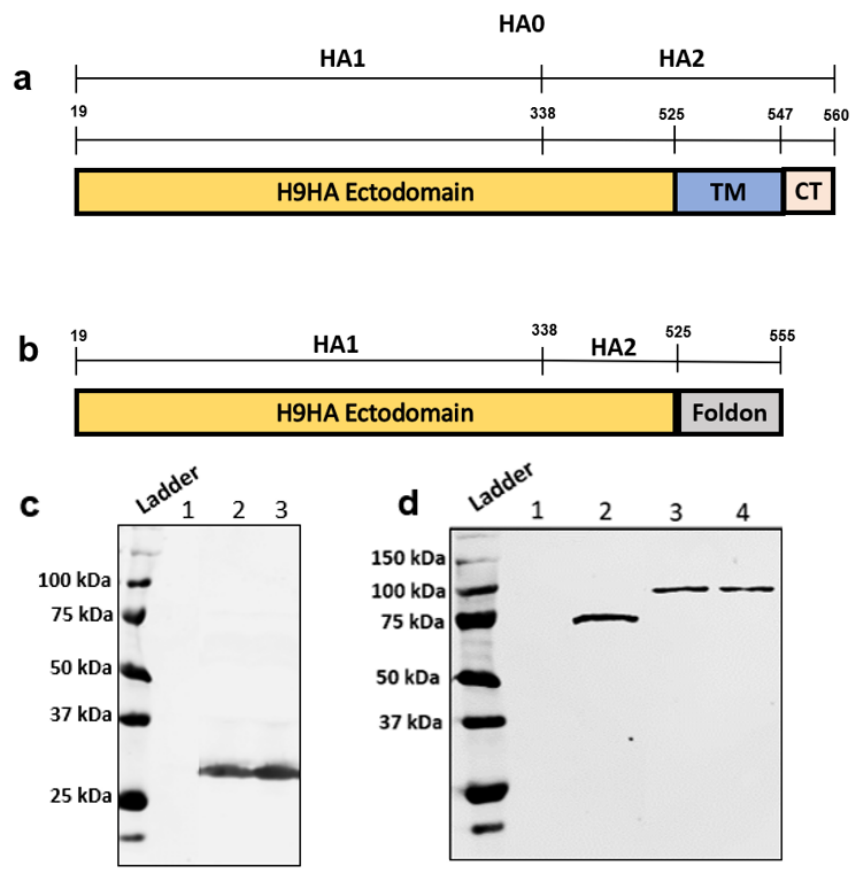
Figure 1. Schematic representation of the H9HA construct and His tag purification of the recombinant proteins ( a ) Full length H9HA precursor (HA0); HA0: 1–560 amino acids (aa), HA1: 19–338 aa, HA2: 339–560 aa, TM=Transmembrane domain (525–547 aa) CT=Cytosolic Tail domain (548–560 aa)